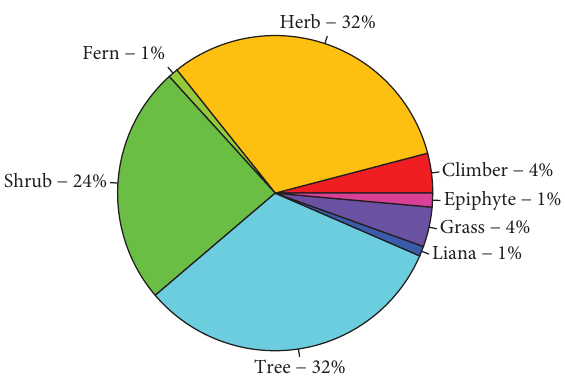
Figure 3: Proportion of life form of plant species collected from